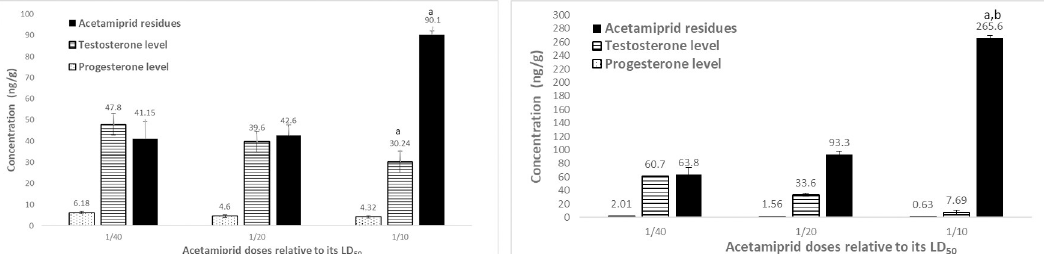
Fig 8. A. Testis testosterone and progesterone levels as well as acetamiprid residues after a month of different treatment of acetamiprid doses on male rats. Data presented as mean S.E. a Significant difference as compared to 1/40 LD 50 , and b significant difference as compared to 1/20 of LD 50 (n = 4, P � 0.05). B. Testis testosterone and progesterone levels as well as acetamiprid residues after 2 months of different treatment of acetamiprid doses on male rats. Data presented as mean S.E. a Significant difference as compared to 1/40 LD 50 , and b significant difference as compared to 1/20 of LD 50 (n = 4, P � 0.05).